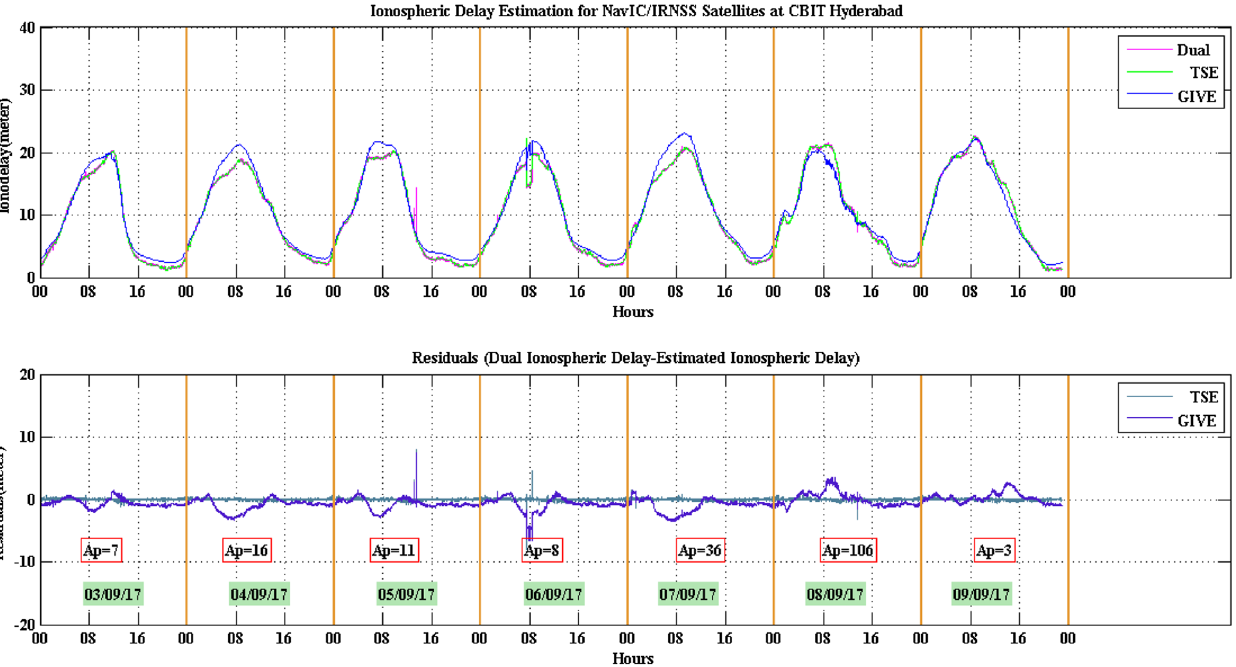
Fig. 10. The average ionodelay performance comparisons of TSE, dual frequency and GIVE model for NavIC/IRNSS satellites at the CBIT Hyderabad on the observation duration (3 – 9 September